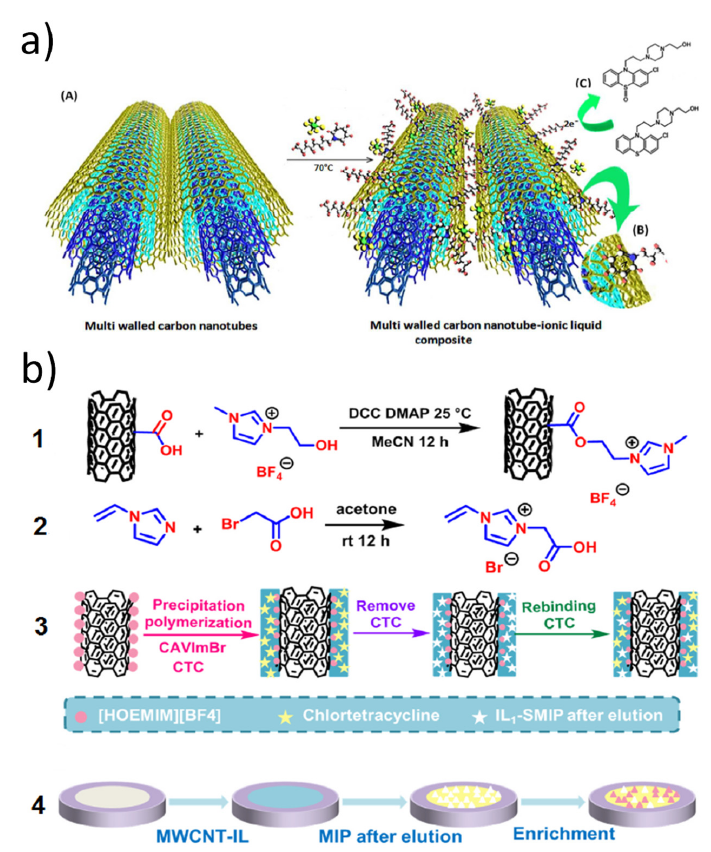
Figure 4. ( a ) Scheme representing dispersion of MWCNT in OPy.PF 6 ( A ), the cation- π interaction ( B ), and oxidation of perphenazine drug ( C ) (reproduced from Fasihi et al. [59], with permission from the Royal Society of Chemistry, 2015). ( b ) Scheme of a MIP-based chlortetracycline sensor representing MWCNT modification by IL, HEMIM.BF 4 (1), synthesis of 1-carboxymethyl-3-vinylimidazolium bromide (2), preparation of MIP at the MWCNT-IL surface (3), and further modification of a GCE (4) (reproduced from Chen et al. [66], with permission from Elsevier, 2021). Antibiotics and antiviral drugs are another group of pharmaceuticals subject to sig- nificant study by electrochemical sensors, given their wide consumption and posed risks to the environment and human health. Still, concerning specifically MWCNT-IL nano- composite-based electrochemical sensors, only four studies were identified in the litera- ture and were focused on pharmaceuticals with less expression. As an example, the direct- acting antiviral daclatasvir, a novel drug used to treat the hepatitis C virus, was deter- mined in serum samples by a GCE modified with different layers. The sequence consisted in applying first a layer of DMF-dispersed MWCNT, followed by BMPy.PF 6 in DMF, a second deposition of MWCNT, and a final layer of iron oxide nanoparticles (Fe 3 O 4 ). By DPV analysis in pH 2, this sensor registered two linear zones from 0.003 to 0.1 µmol L − 1 and from 0.5 to 15 µmol L − 1 , accomplishing a high sensitivity of 154 µA µmol − 1 L and a very low LOD of 4 × 10 − 5 µmol L − 1 with these results being determined in diluted serum medium [64]. Suitable results have also been achieved in the simultaneous sensing of tu- berculosis-treating drugs, ethambutol (sensitivity of 17.4 µA µmol − 1 L and LOD of 0.02 µmol L − 1 ) and pyrazinamide (sensitivity of 13.4 µA µmol − 1 L and LOD of 0.01 µmol L − 1 ). The configuration of this sensor consisted of the modification of a GCE with a layer of MWCNT decorated with cobalt ferrite nanoparticles (CoFe 2 O 4 ). Interaction between